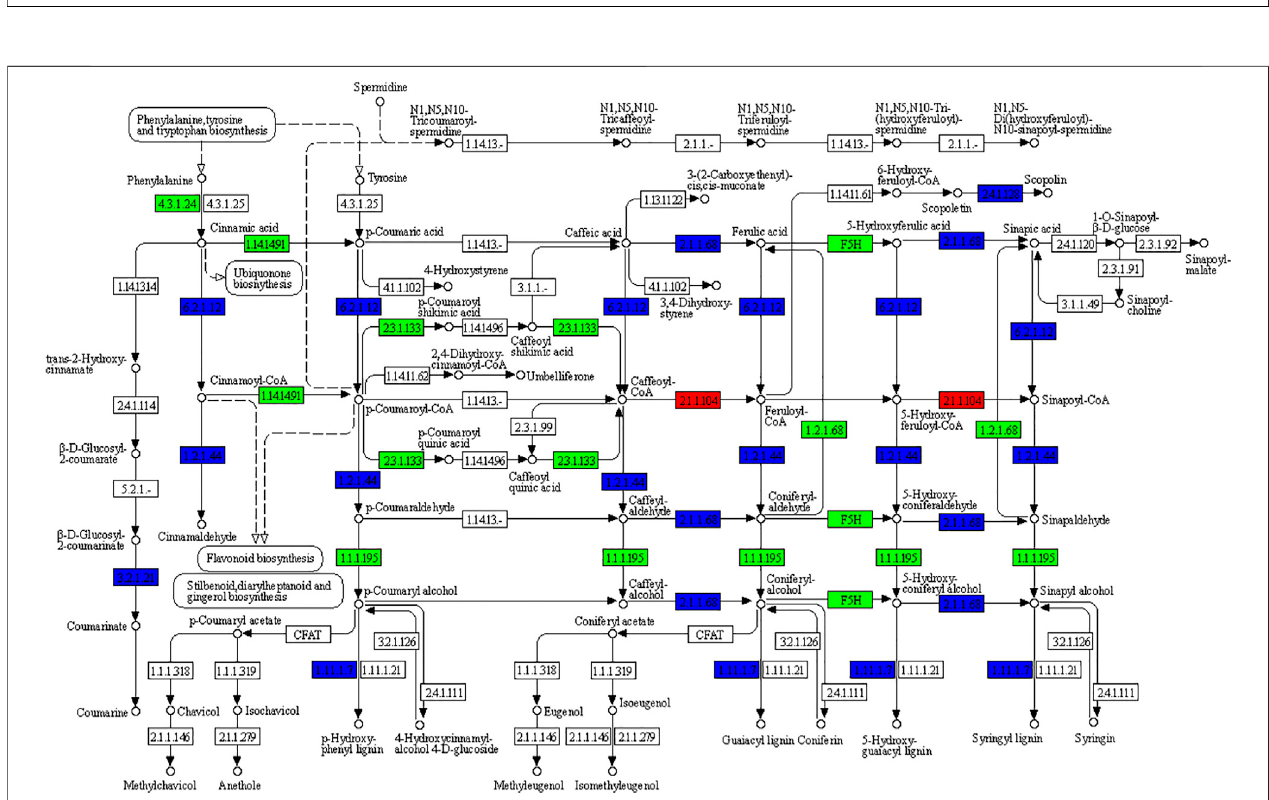
FIGURE 4 | KEGG pathway map representing the differential regulation of phenylpropanoid biosynthesis pathway in Young (Y) vs. Mature (M) ginger rhizome. The numbersintheboxesrepresentE.Cnumbersoftheenzymes.Red,green,andbluecolorsrepresentup-,downregulated,andvariablyregulatedgenesbetweenYandM ginger tissues, respectively. For details on the differential regulation and log2 fold change values, please refer to the Supplementary Table S2 .